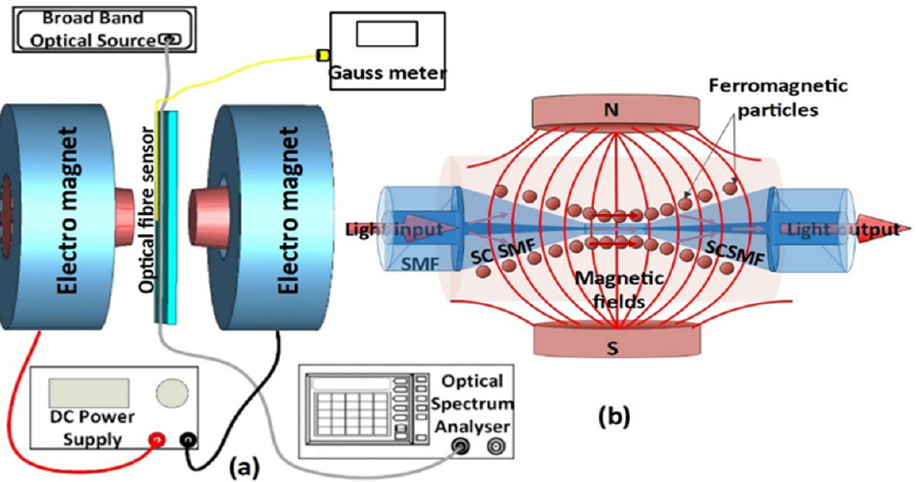
Figure 1. Schematic diagram of ( a ) experimental setup and ( b ) tapered small-core single-mode op- tical fibre sensor surrounded by magnetic fluid, for magnetic field sensing. fibre sensor surrounded by magnetic fluid, for magnetic field